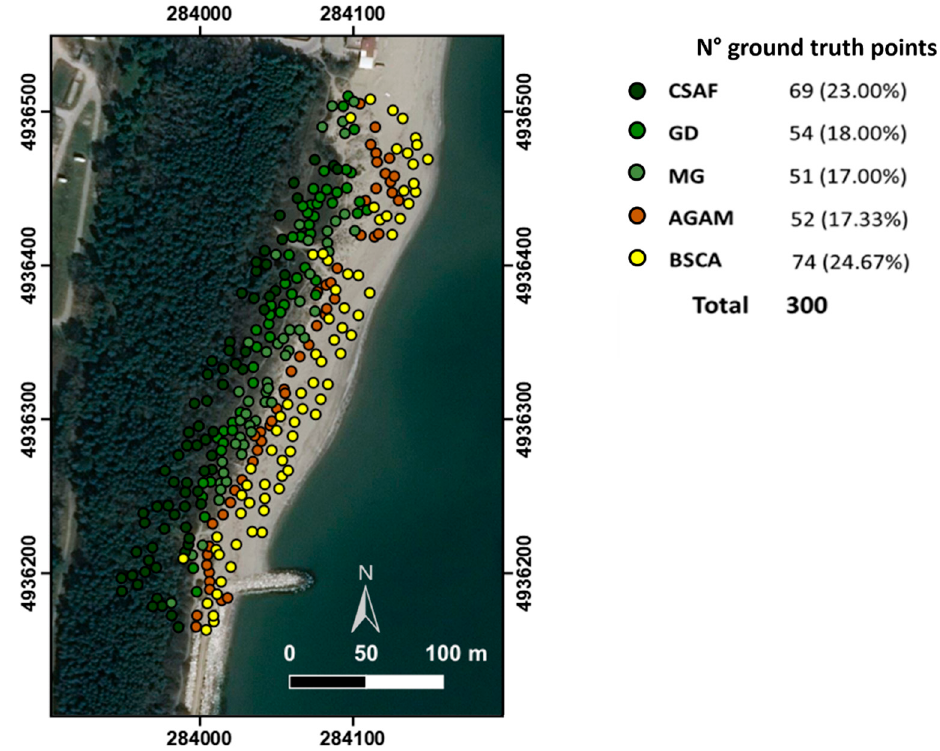
Figure 3. Map of the ground truth points used to classify the validation of results. For abbreviations, see main text.